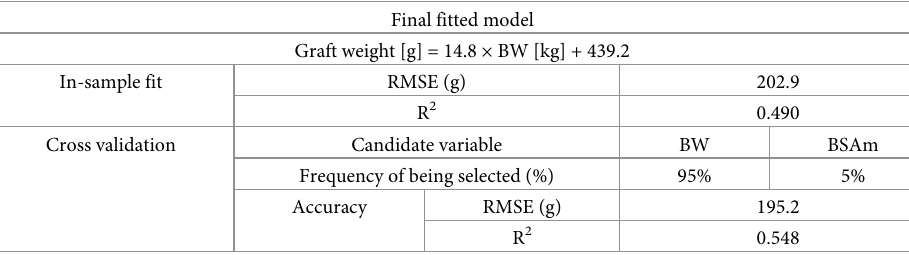
Table 3. Final fitted model with results of cross